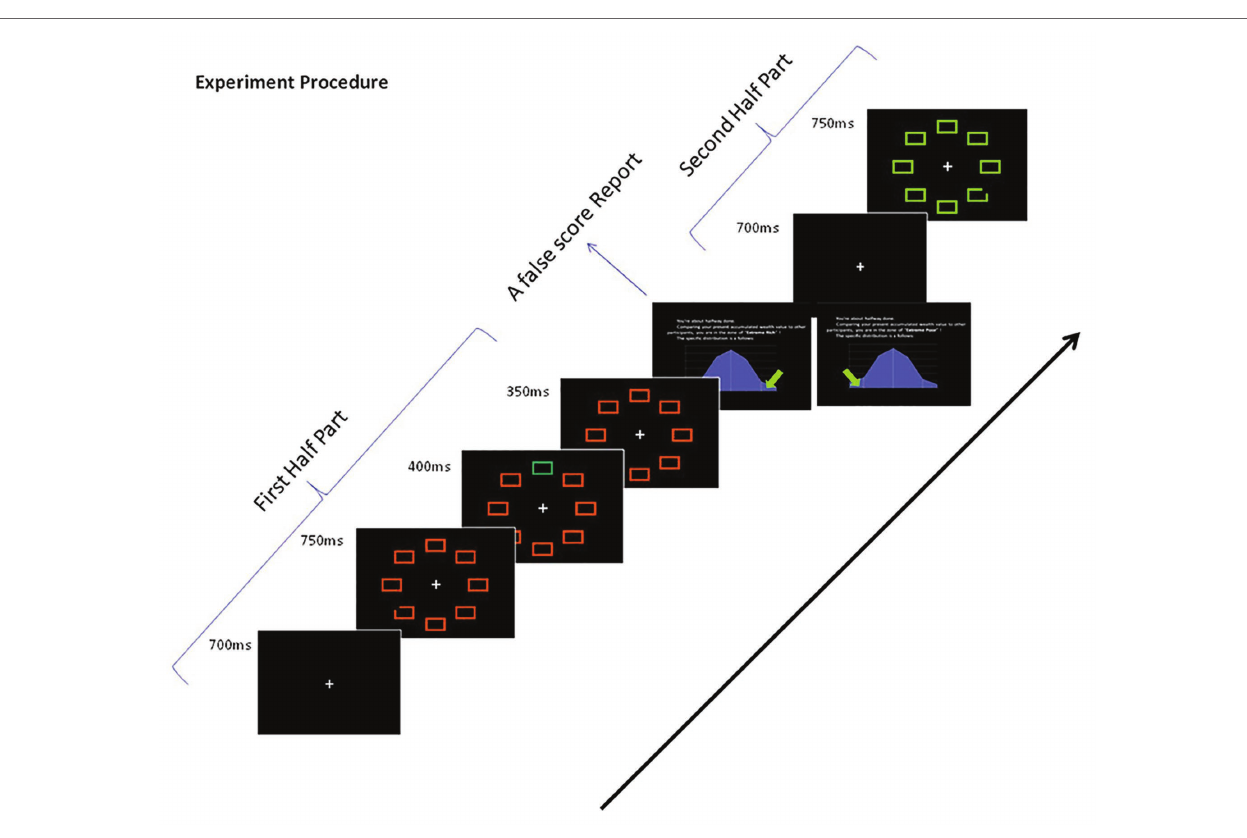
FIGURE 2 | Sample of the visual search task trial